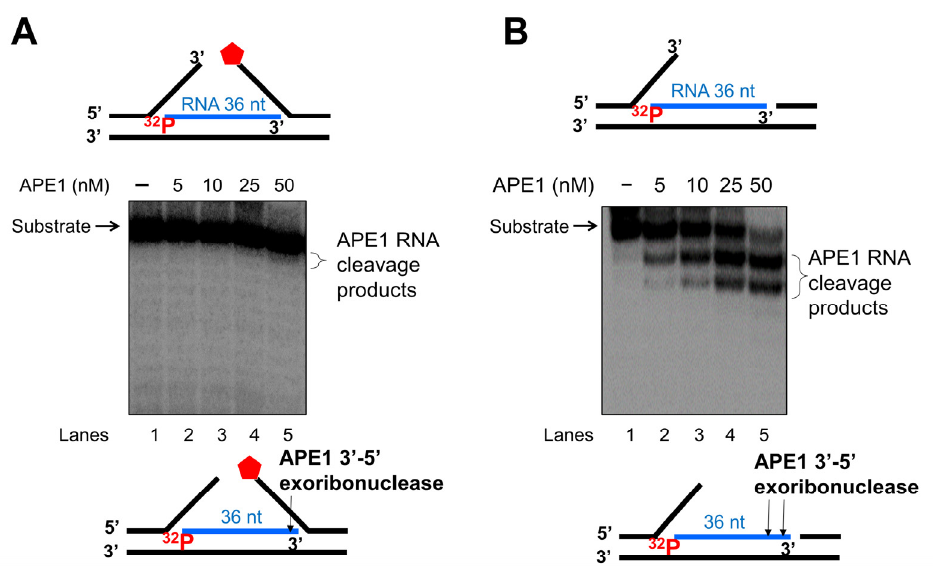
Genes 2023 , 14 , x FOR PEER REVIEW 14 of 21 Figure 7. APE1 3 (cid:48) -exonucleolytic cleavage of RNA on R-loops intermediates. APE1 3 (cid:48) -exonucleolytic cleavage on RNA on R-loops was examined by incubating different concentrations of APE1 (5–100 nM) with the substrate (25 nM) that mimics the R-loop intermediate containing double-flaps or a 3 (cid:48) -flap alone at 37 ◦ C for 15 min. Substrates were 32 P-labeled at the 5 (cid:48) -end of the RNA strand of the substrate. ( A ) The activity of APE1 cleavage of the RNA strand in the double-flap R-loop substrate. ( B ) APE1 exonucleolytic cleavage of the RNA strand on the R-loop substrate containing a 3 (cid:48) -flap alone. Lane 1 represents the substrate only. Lane 2–6 represents the reaction mixture with increasing concentrations of APE1. Substrates and products were separated in a 15% urea-denaturing polyacrylamide gel and detected by phosphorimagery. The experiments were performed in triplicate.